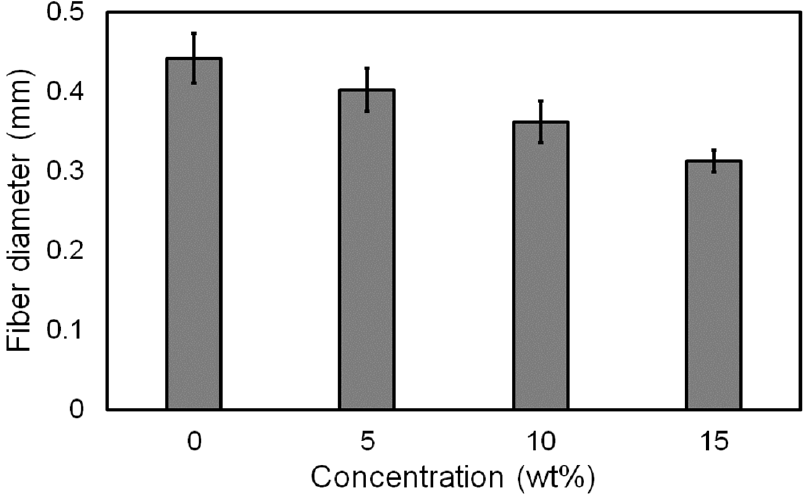
Figure 7. Fiber diameter according to pigment concentration. Pigment concentration also affects the surface quality of the printing, as shown in Figure 8. While the surface of the printing made of pure PCL (i.e., 0 wt.% of pigment) was relatively smooth, the surfaces of printing made of 5, 10, and 15 wt.% pigment–PCL mixtures had many pores. As shown in the figures, the addition of pigment powders induced the aggregation of molten PCL–pigment powders.